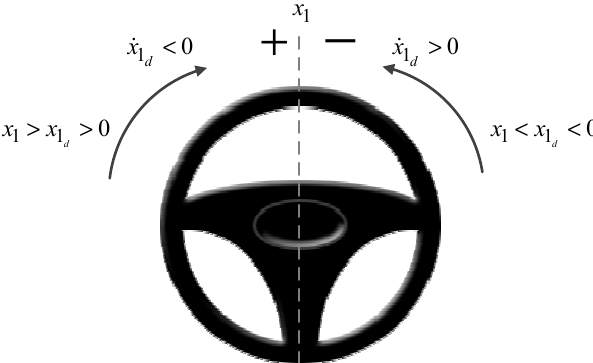
Figure 1. Steering wheel regions for helpful self-aligning torque.